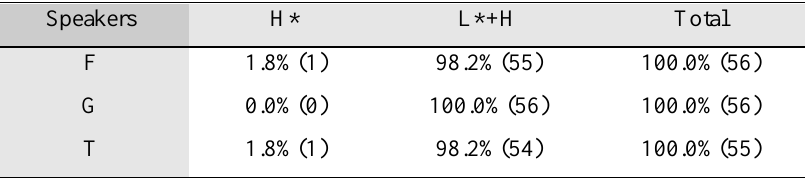
Table I. Tonal events associated with the head  of the I-initial non-branching  . Percentages and number of tokens (in